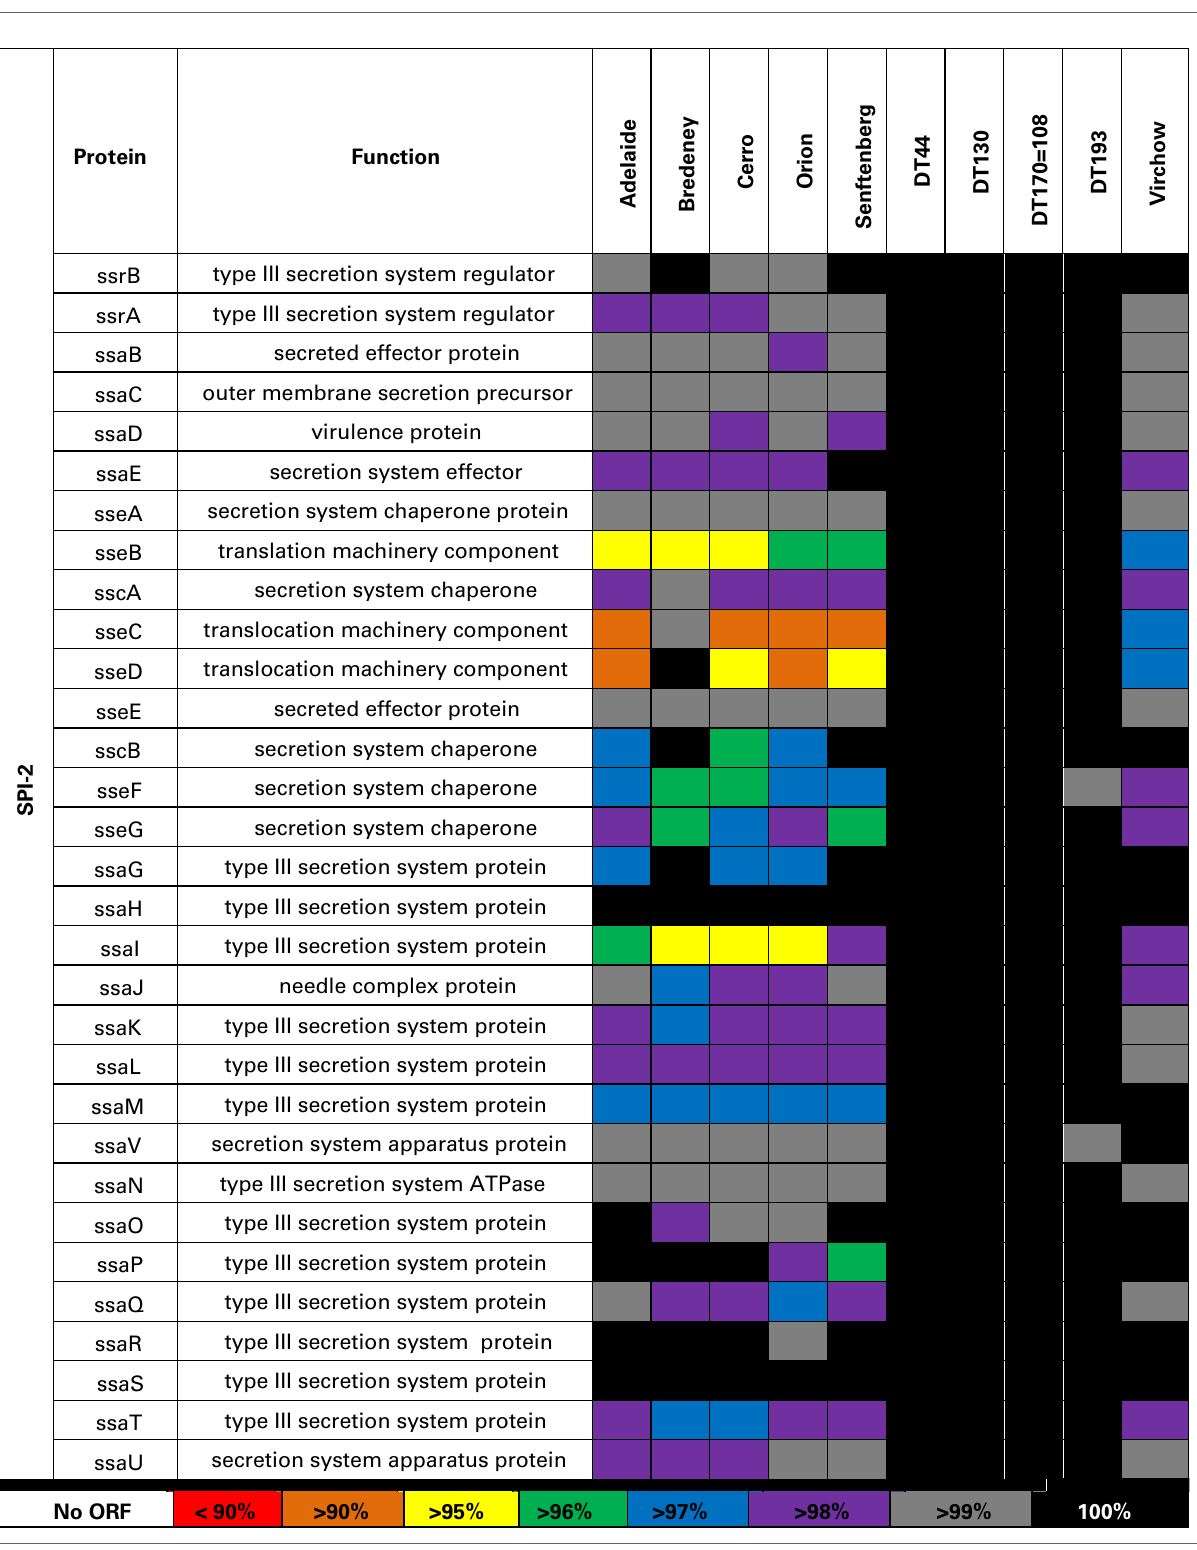
Table 5 | Sequence variability within